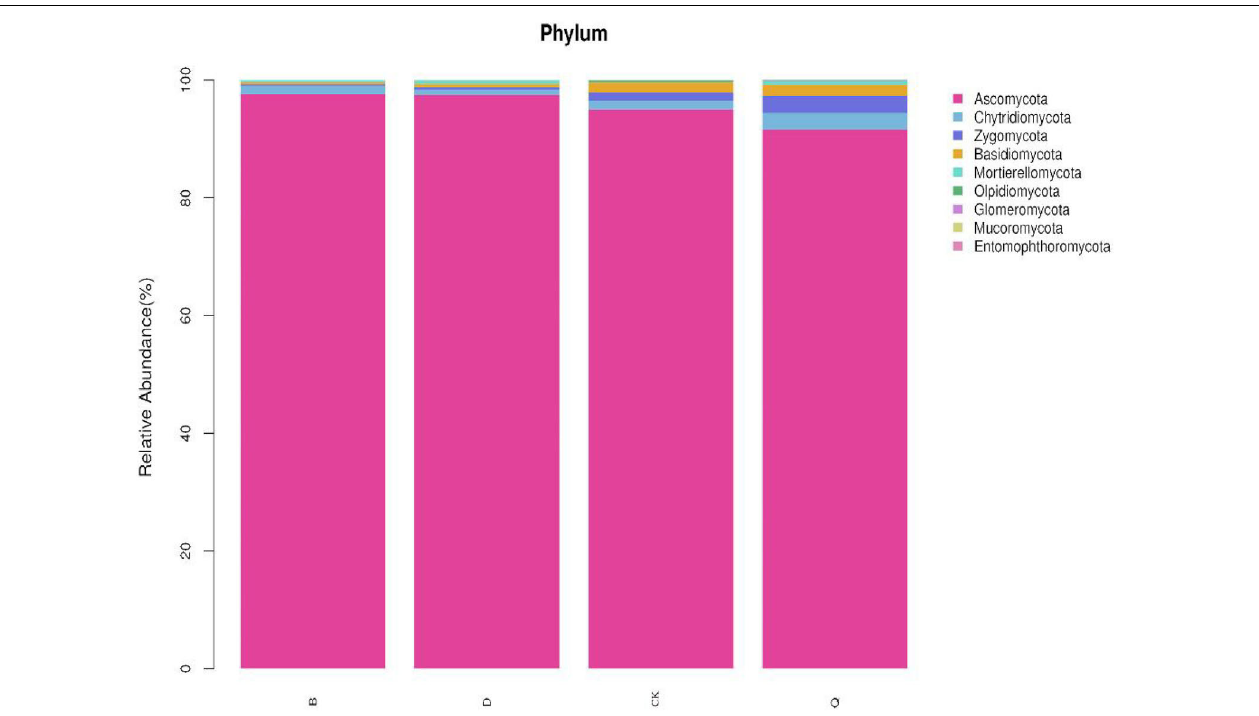
FIGURE 2 | Relative abundance of dominant fungi in continuous tomato cropping substrates under different treatments. Fungal phylum in different rotation treatments. Treatment abbreviations are defined in Figure 1